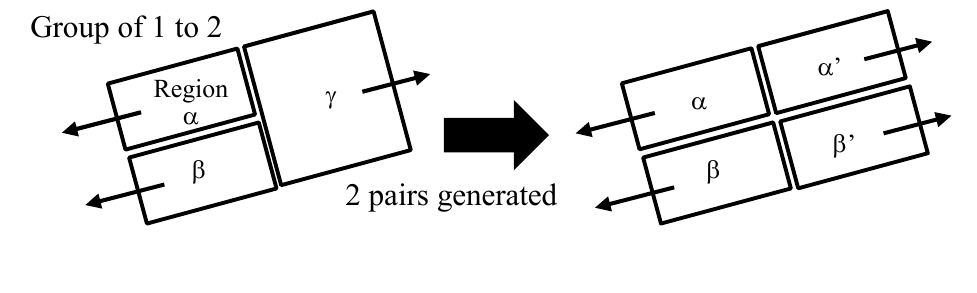
Figure 5. Generation of two gable-roof buildings when the four roofs are not correctly extracted. These regions are called a group of 1 to 2 roofs in this paper. Region  is divided into two regions, Region  ′ and Region 